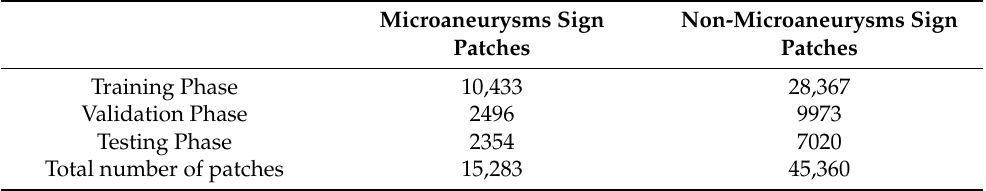
Table 1. Details of microaneurysms sign and non-microaneurysms sign patches.